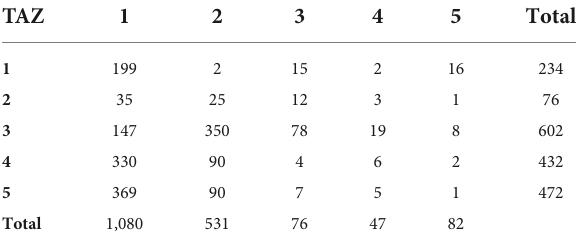
TABLE 1 Solution to the in-class activity shown in Figure 2 .